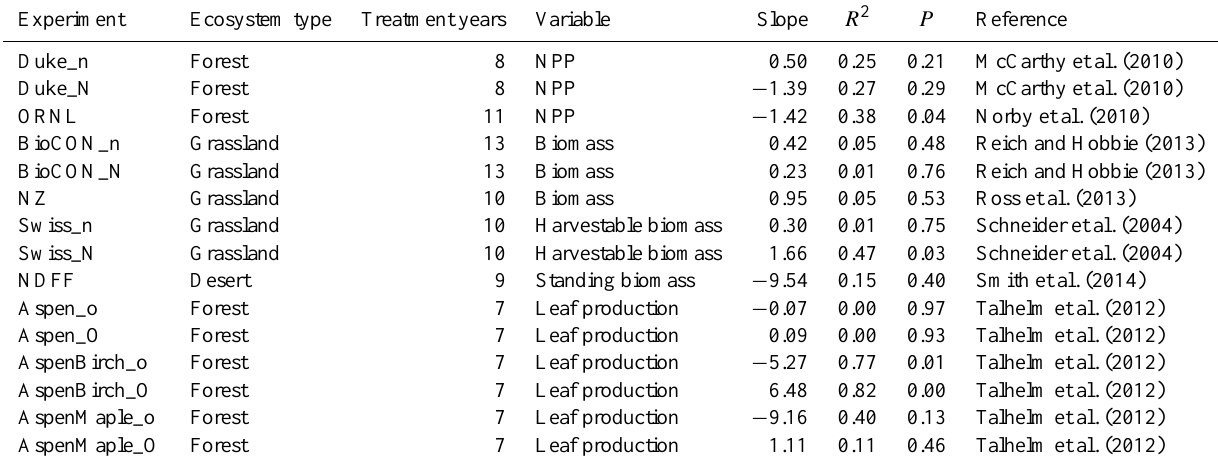
Table 1. Results on the effect of CO 2 enrichment on ecosystem NPP (or biomass or leaf production) in decadal free air CO 2 enrichment (FACE) experiments over treatment time. The values of the slope, R 2 and P in the linear regression in Fig. 4 are shown. The lower and upper n (i.e., n and N) in Refs. Schneider et al. (2004), McCarthy et al. (2010) and Reich and Hobbie (2013) mean without and with N addition, respectively. The lower and upper o (i.e., o and O) in Ref. Talhelm et al. (2012) mean without and with O 3 treatment,